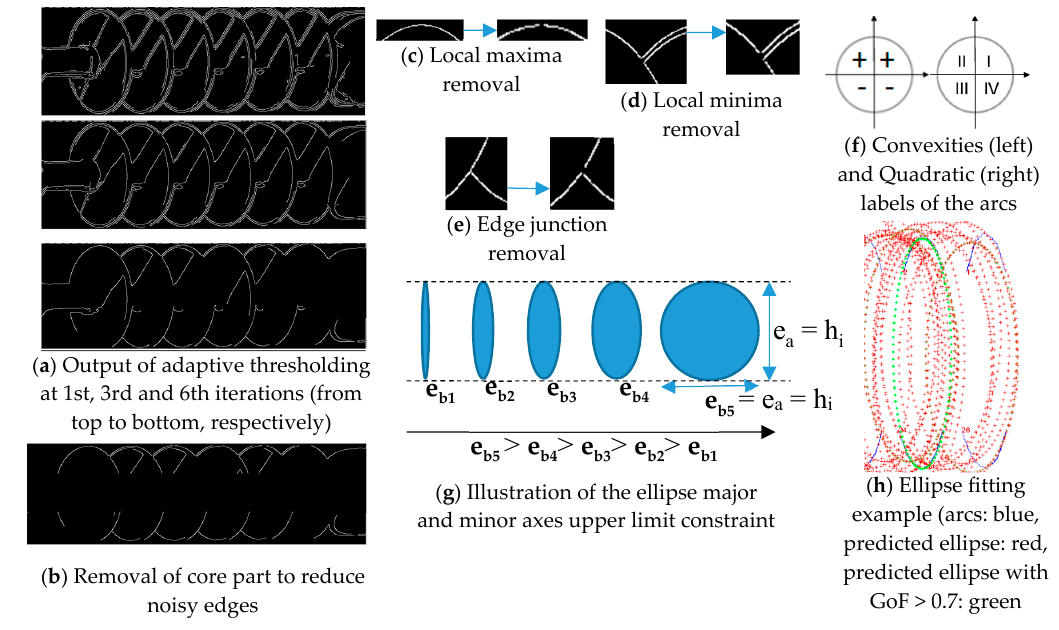
Figure 6. Pictorial representation of the different steps in the ellipse detection algorithm.